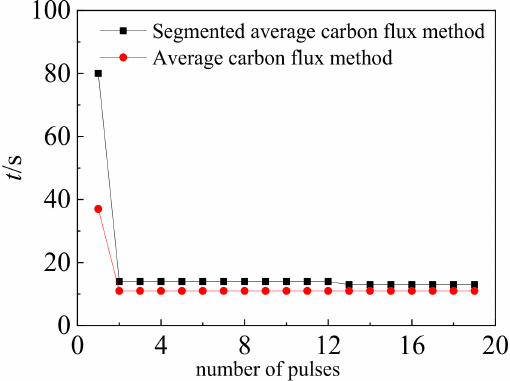
Figure 4. Carburizing time of each pulse obtained via di ff erent carbon flux measurement methods.